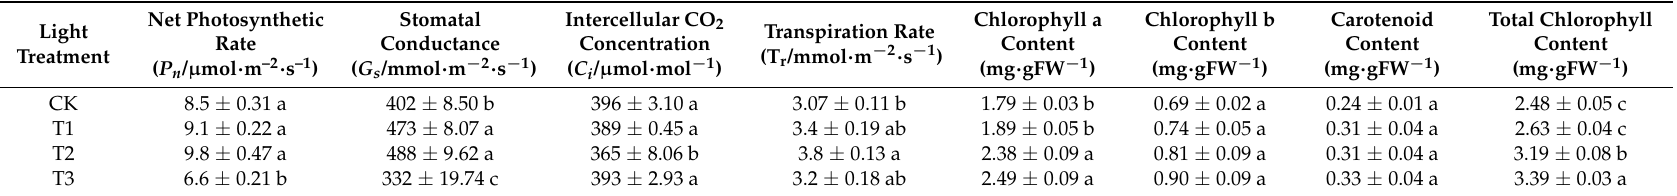
Table 3. Effect of supplementary light treatments on photosynthetic parameters and photosynthetic pigments of pepper